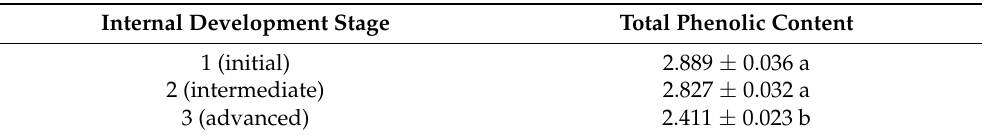
Table 4. Total phenolic content (g kg − 1 ) for different internal development stages (1: initial; 2: inter- mediate; 3: advanced) of ‘Lorca’